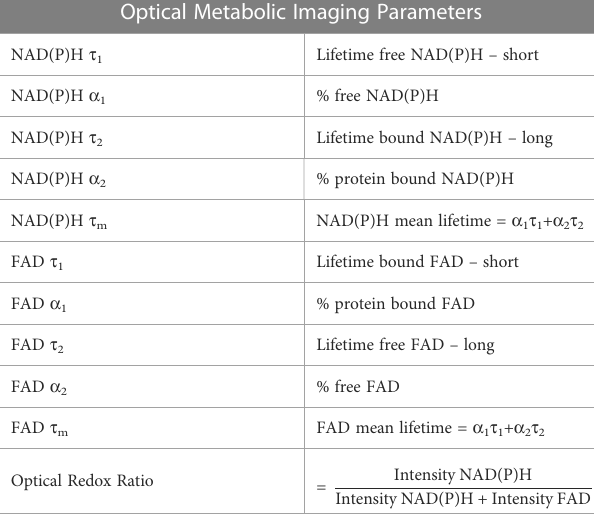
TABLE 1 Optical metabolic imaging